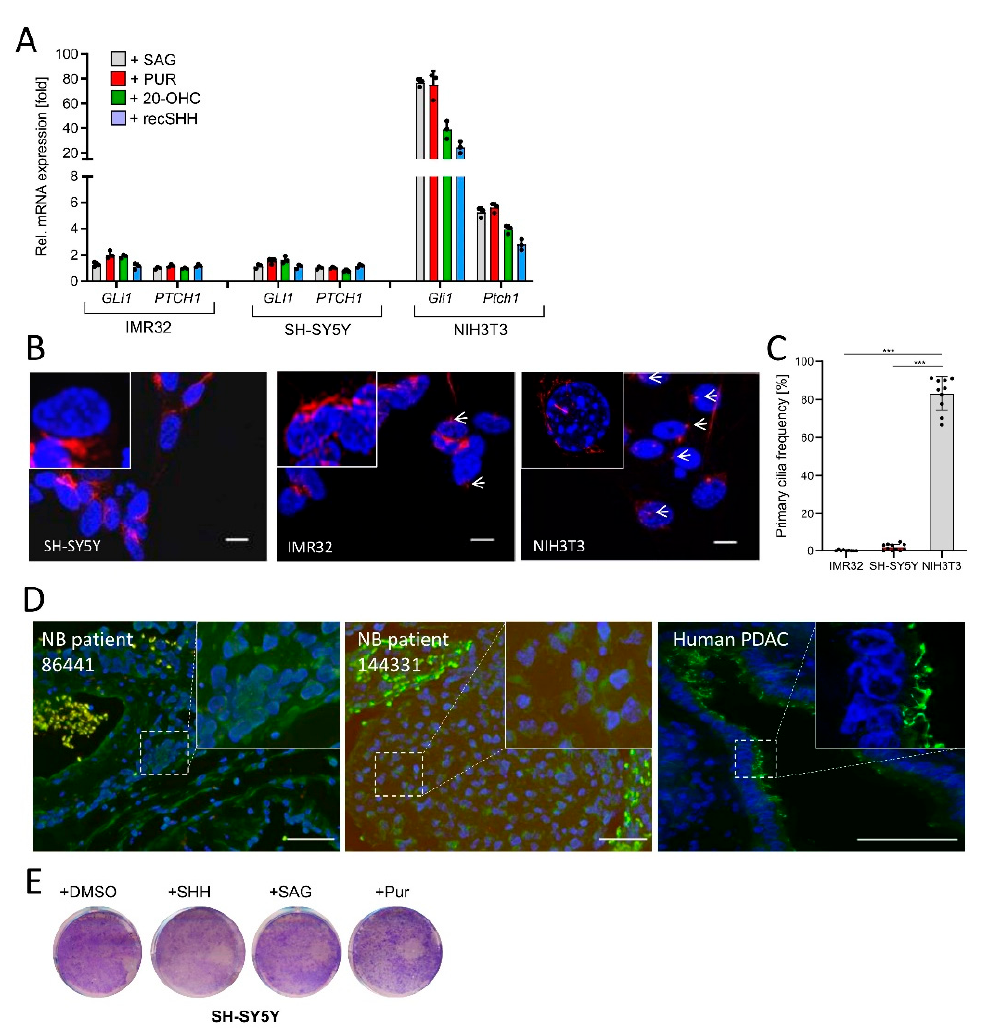
Figure 2. NB cells are Hh-unresponsive and lack primary cilia. ( A ) Hh target gene expression ( GLI1, PTCH1 ) in IMR32 and SH-SY5Y cells exposed to SAG (100 nM), Purmorphamine (PUR, 2 µM), 20(S)-Hydroxy-Cholesterol (20-OHC, 10 µM) or recombinant SHH (recSHH, 0.4 µg/mL), each for 48 h. Shown is the fold change in mRNA expression compared to solvent. Mouse NIH3T3 cells were used as positive control. Values are mean of n = 3 ± SD. ( B ) Immunofluorescent images of IMR32, SH-SY5Y and NIH3T3 cells starved for 48 h in 0.5% FBS-containing medium and stained for the primary cilium marker acetylated α -Tubulin (AcTub, in red). Nuclei appear in blue (DAPI). Scale bar 10 µm. White arrows depict primary cilia. ( C ) Quantification of primary cilia as shown in ( B ). At least n = 300 cells of each cell line were counted. Each dot represents a field of view. Mean ±SD. ( D ) Primary cilia (AcTub, green)/Basal body (PCM1, red) staining of human NB tissue. Human pancreatic cancer tissue was used as positive control (AcTub, green). Nuclei appear in blue (DAPI). Scale bar in each panel is 50 µm. ( E ) Colony stain of SH-SY5Y cells treated with DMSO, SAG (100 nM), Purmorphamine (PUR, 2 µM), or recombinant SHH (recSHH, 0.4 µg/mL) for 5d. One example of two is shown. Significances were indicated as *** p < 0.001.